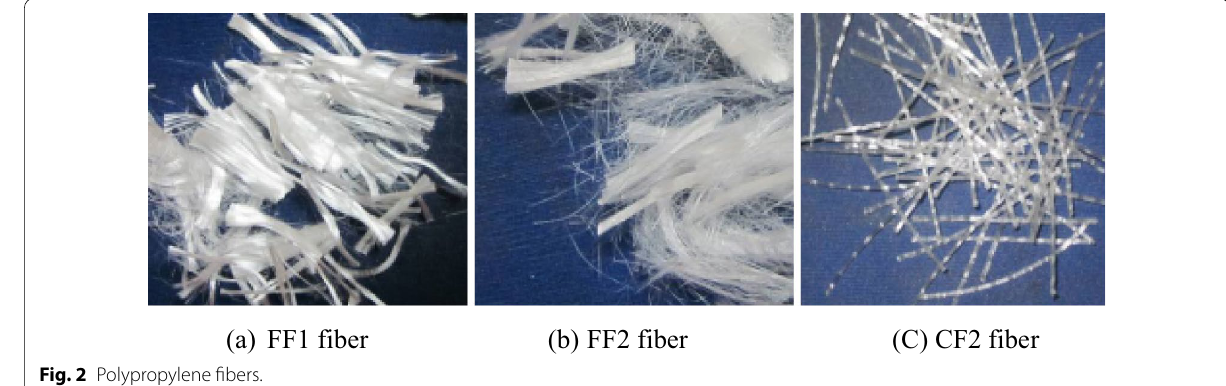
Fig. 2 Polypropylene fibers.